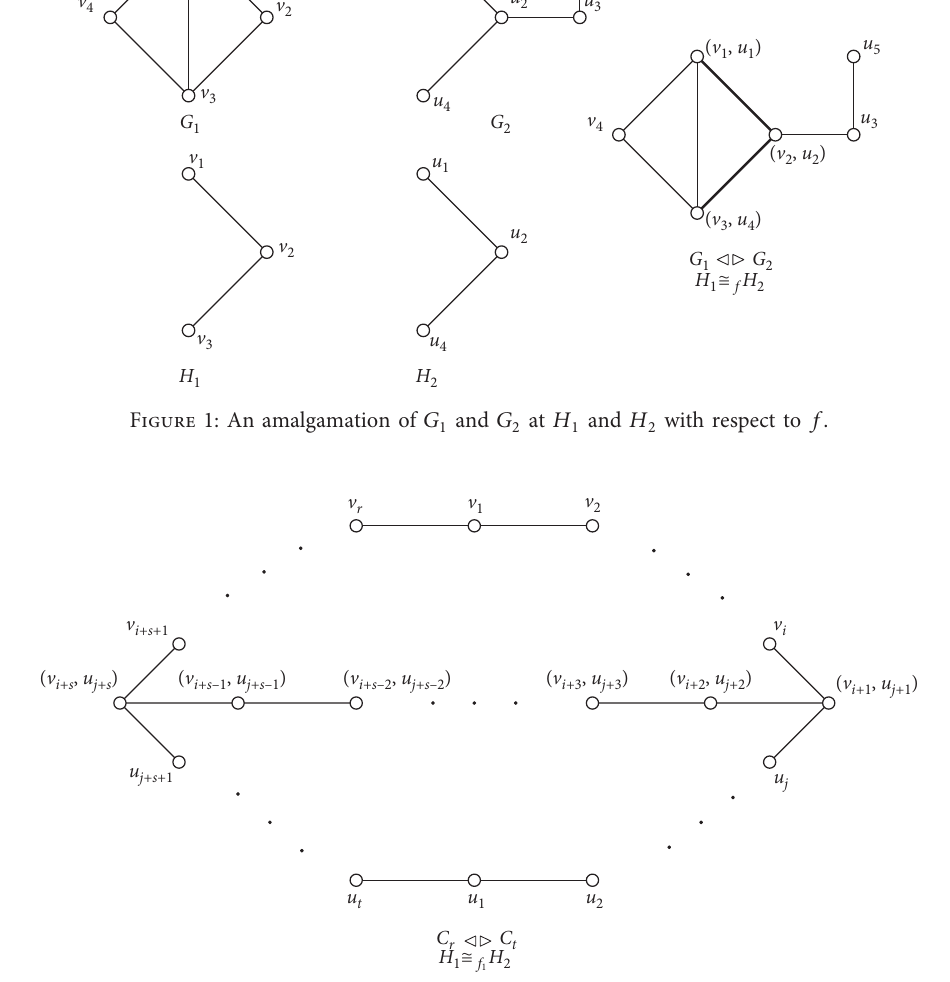
C r and t at connected proper subgraphs